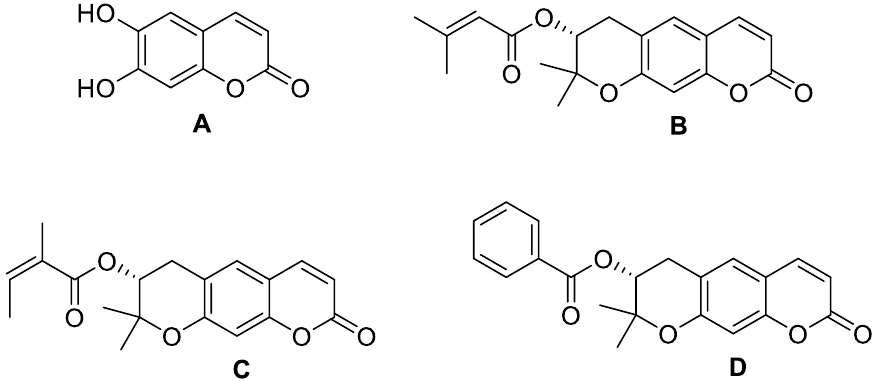
Figure 22. Chemical structures of esculetin ( A ), grandivittin ( B ), agasyllin ( C ), and aegelinol benzoate ( D ).